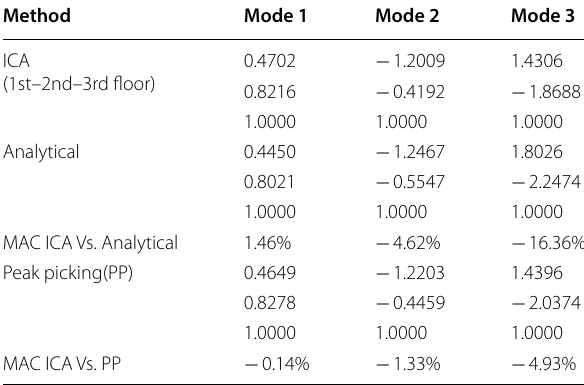
Table 4 The mode shapes by ICA